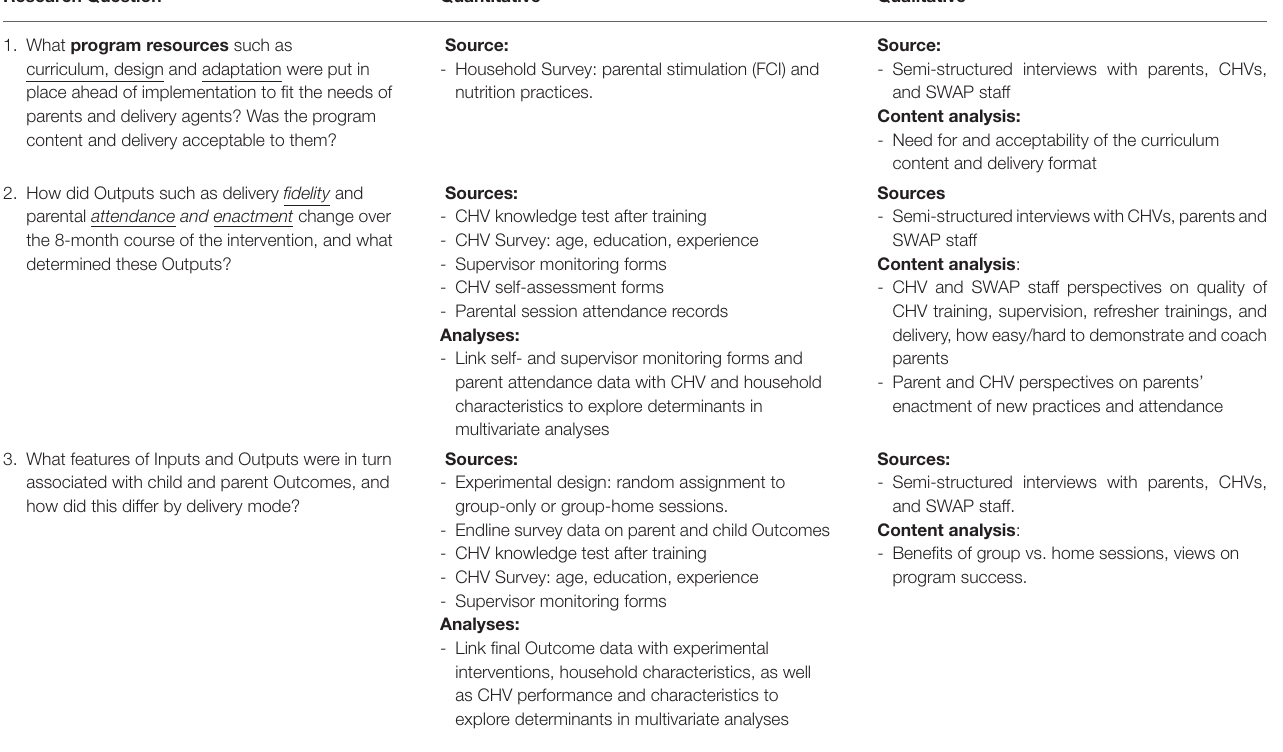
TABLE 1 | Research questions and data sources crosswalk and analysis